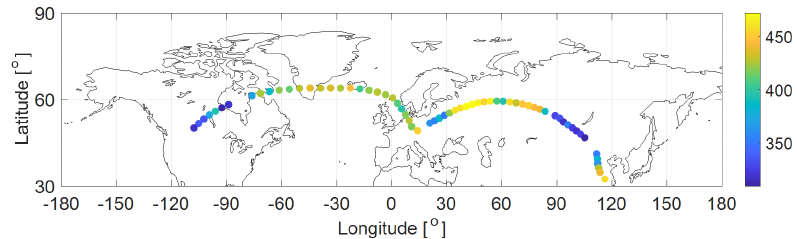
Figure 7. Two IAGOS–CARIBIC example flights from Munich to Los Angeles and from Munich to Shanghai (in February 2019) with OCS MRs according to the color scale